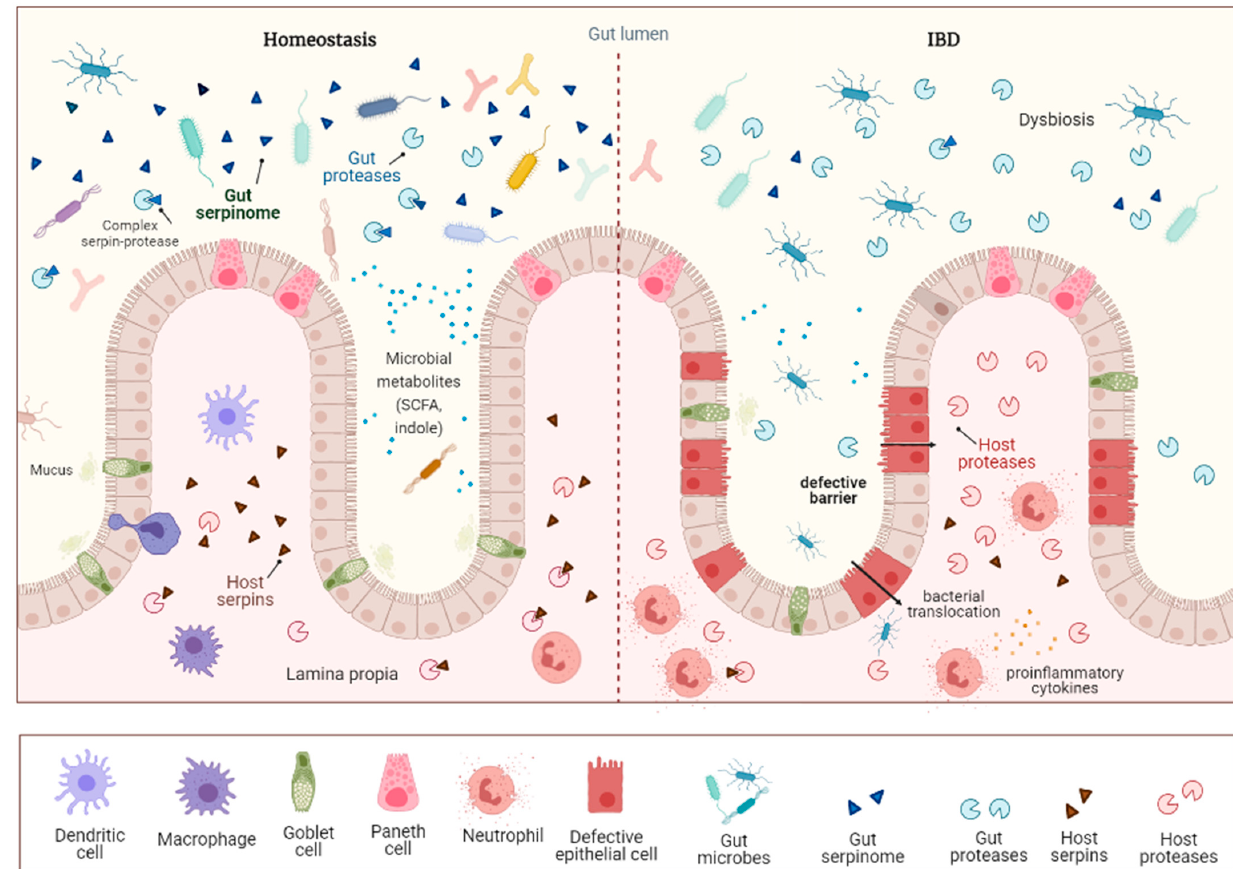
Figure 1. Schematic illustration of gut serpinome involvement in intestinal homeostasis and IBD. During homeostasis, the gut microbiota elicits an immune tolerance phenotype in the host. The activity of luminal serine and cysteine proteases is tightly regulated by their specific serpins of both gut microbial and host origin. A key feature of IBD is the alteration of the composition of the gut microbiota, dysbiosis, characterized by the decrease in microbial diversity with a loss of bene- ficial symbionts and the expansion of pathobionts. The dysregulation of the proteolytic balance with an increased protease activity over serpins alters the intestinal barrier and exacerbates inflammation. SCFA: short-chain fatty acid.